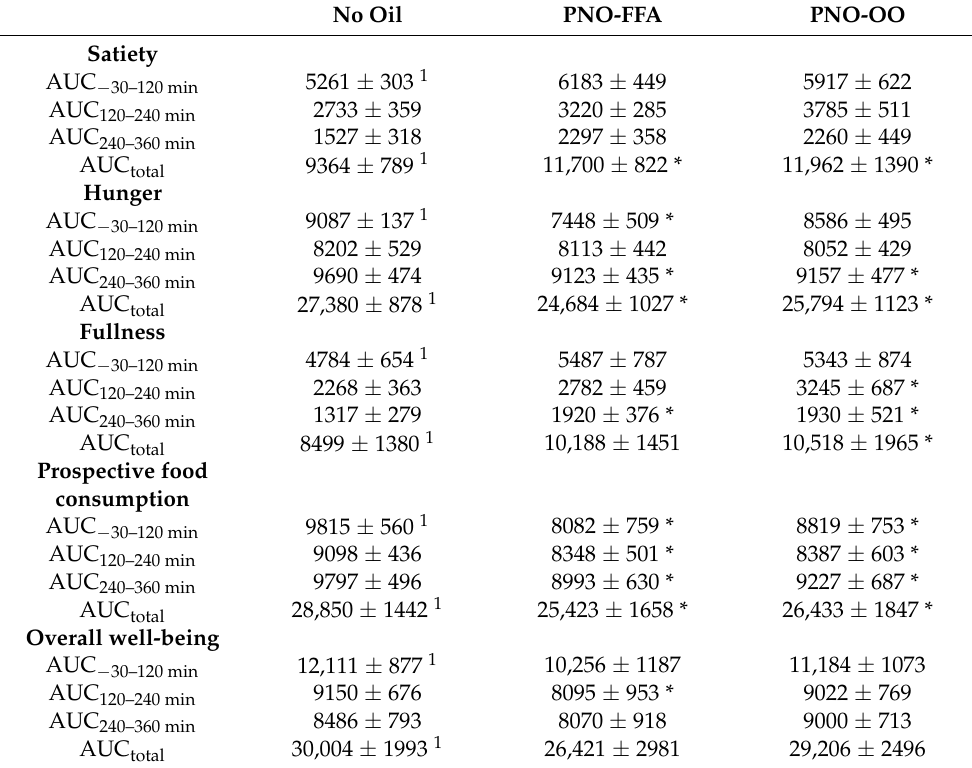
Table 3. Effects of PNO-FFA and PNO-OO on AUC appetite